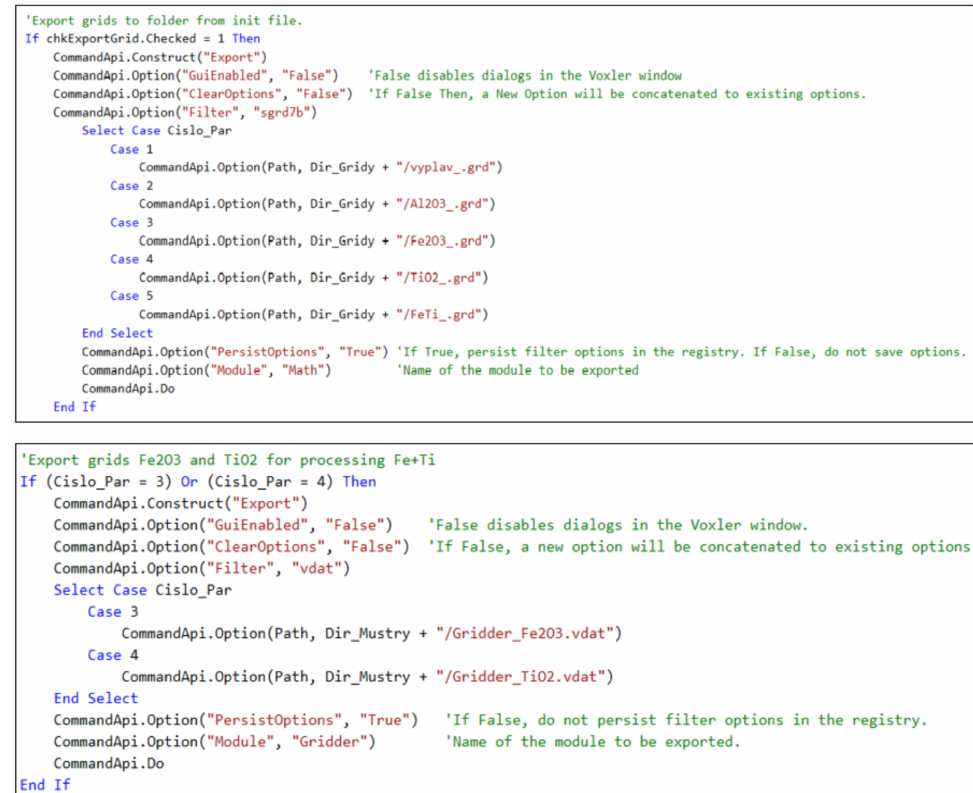
Figure 12. Example of program code using Voxler automation model. Figures 13–15 demonstrate 3D visualization of the monitored technological parameters. These results are outputs of the Kaolin_A software in the Voxler environment.